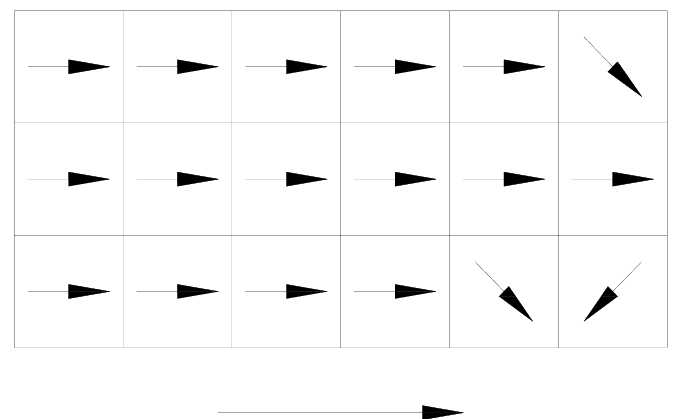
Figure 7. Direction of the maximum inductance in each sector of the